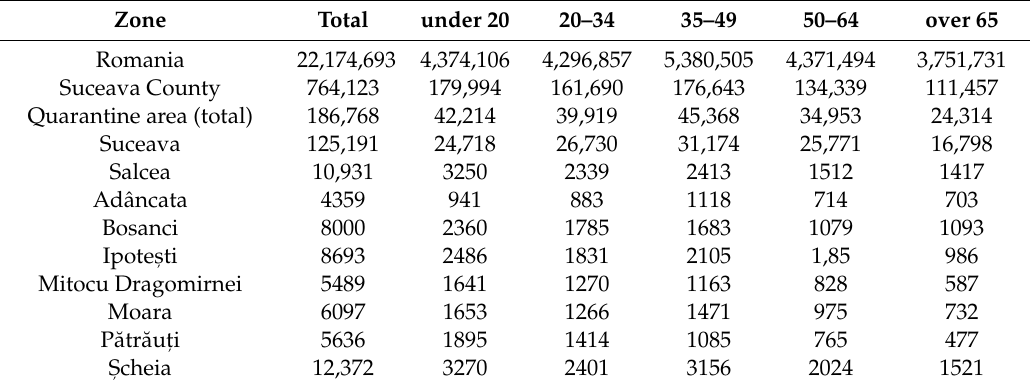
Table 1. Population in the quarantined area of Suceava county.